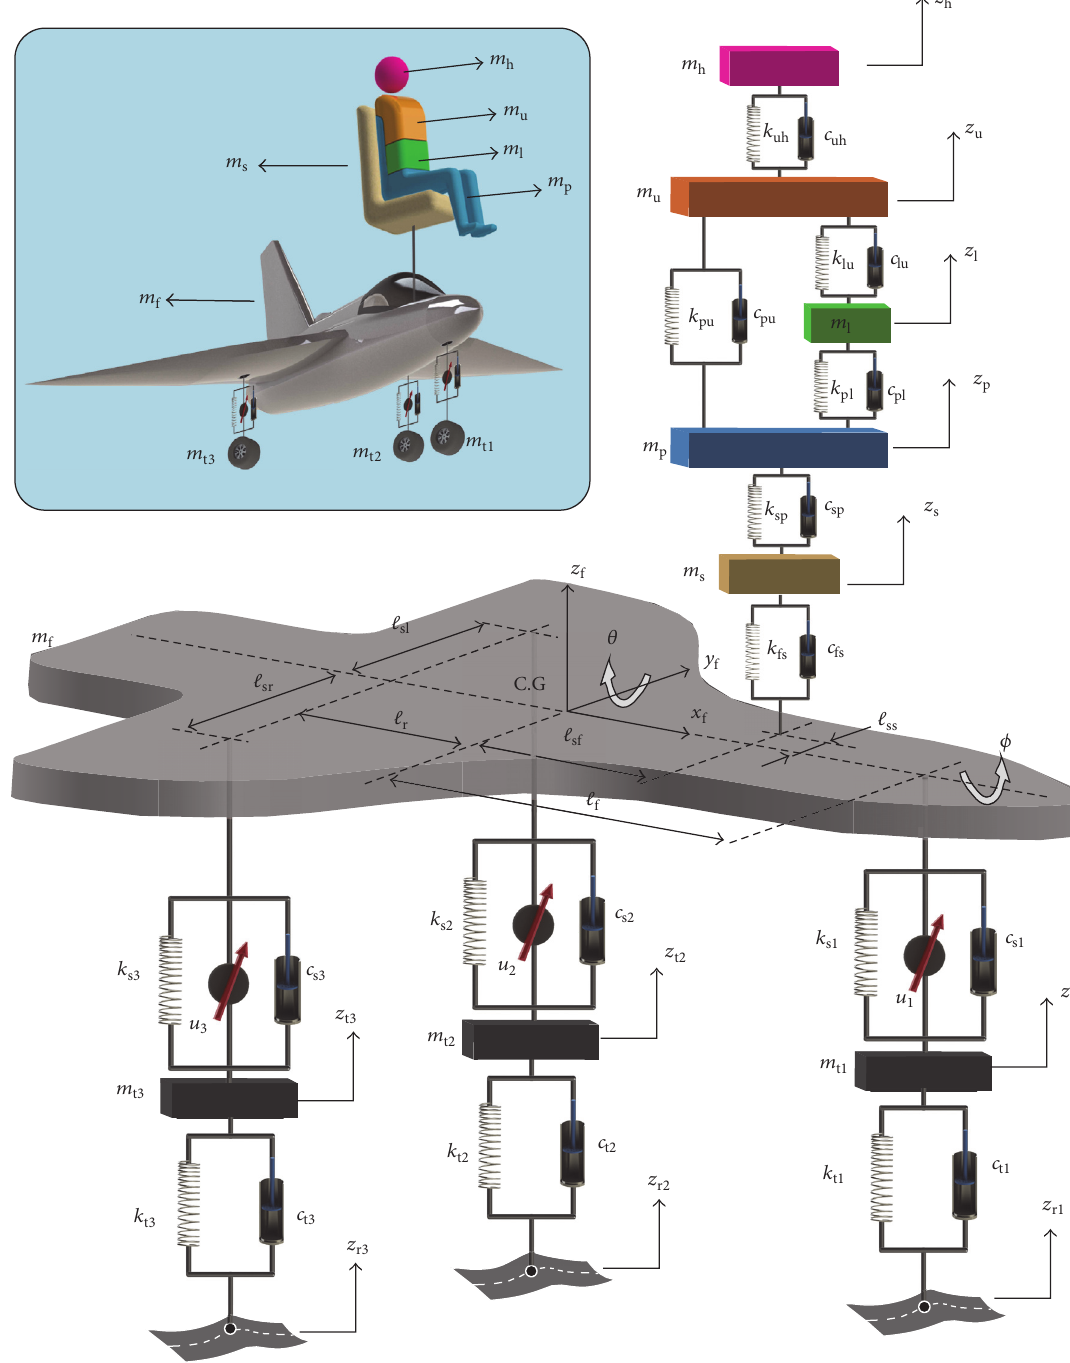
Figure 1: Full aircraft vibration model having active landing gears and biodynamic pilot body subject to runway excitation.